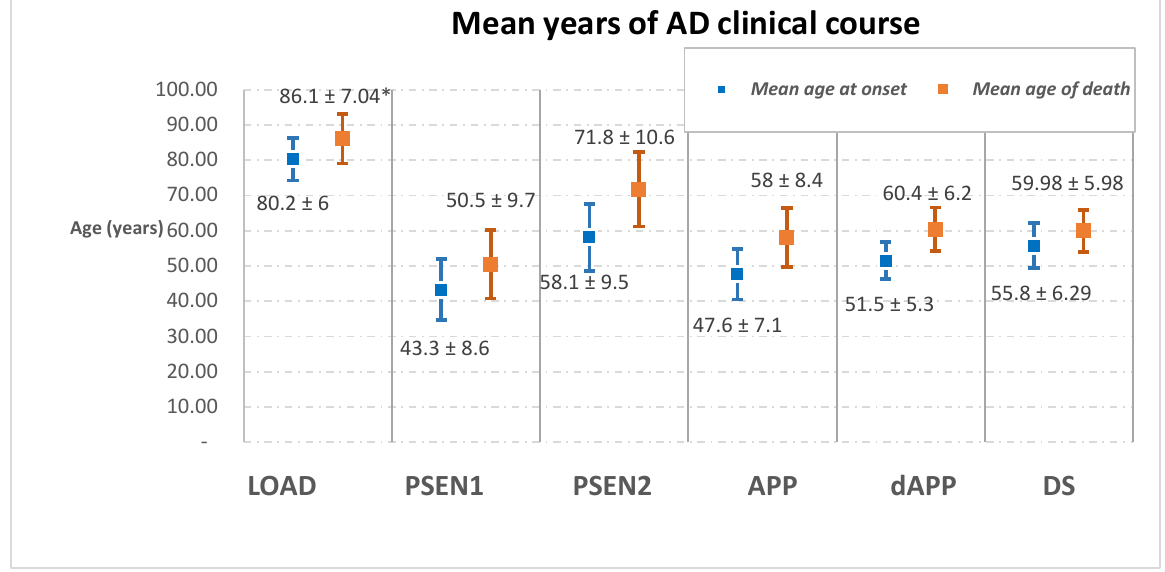
Figure 2. Schematic representation of the average duration of Alzheimer’s clinical course that has been reported for the sporadic form of the disease (LOAD) [67], the familial one (PSEN1, PSEN2, APP and dAPP) [68]; and AD in the DS population (DS) [61]. * The mean age of death for LOAD was calculated from the mean age at onset plus the average survival; LOAD= Late- onset Alzheimer’s disease.